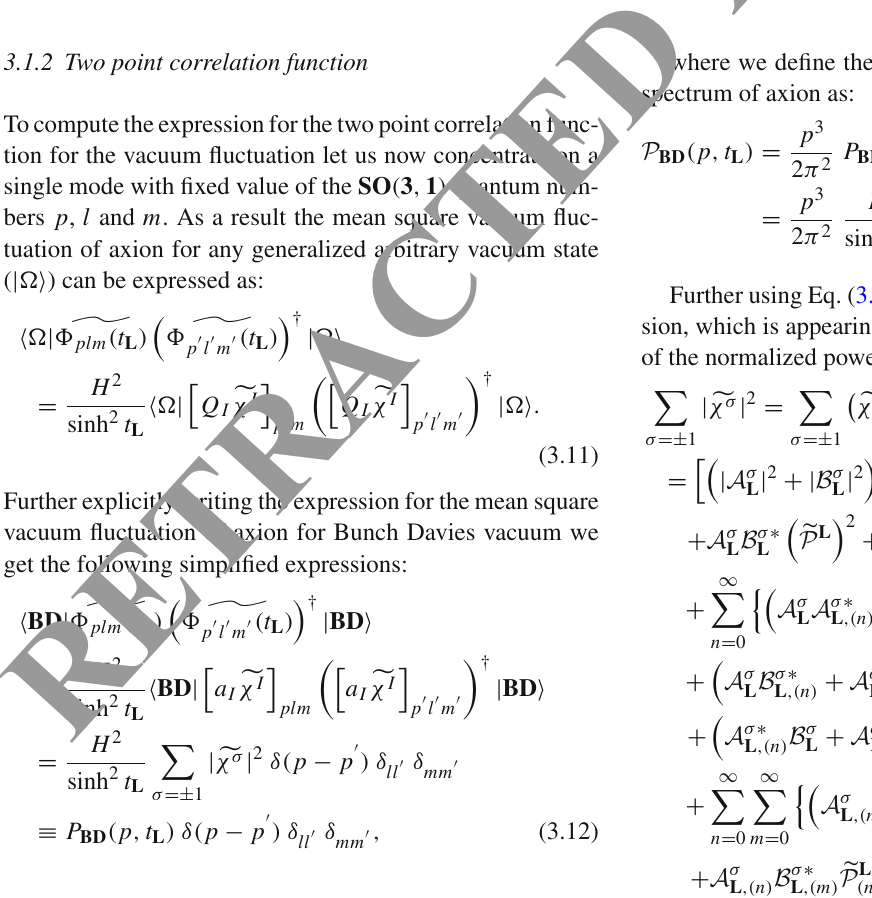
Fig. 5 Schematic diagram for the computation algorithm of field operator expansion method for entangled state of axion in de Sitter hyperbolic open